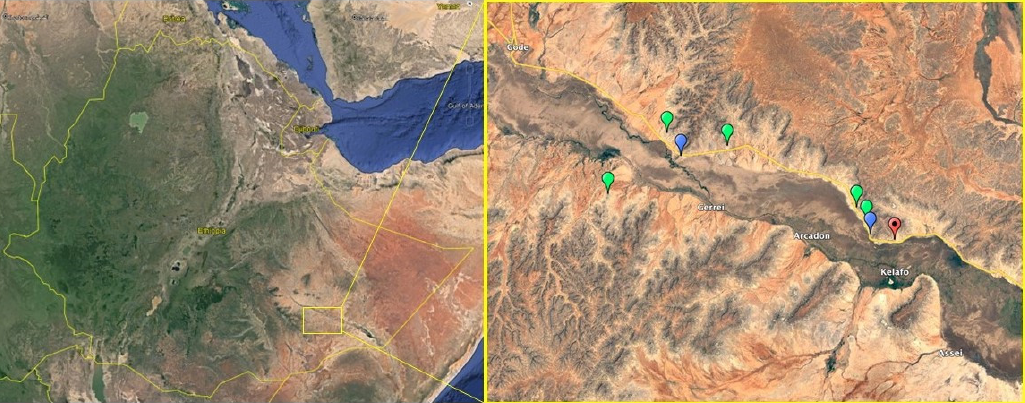
Figure 1. Map of locations where B. ogadensis occurs. Red pins are locations previously recorded where it was not found; blue pins are locations previously recorded where it was found; green pins are new locations not previously recorded.